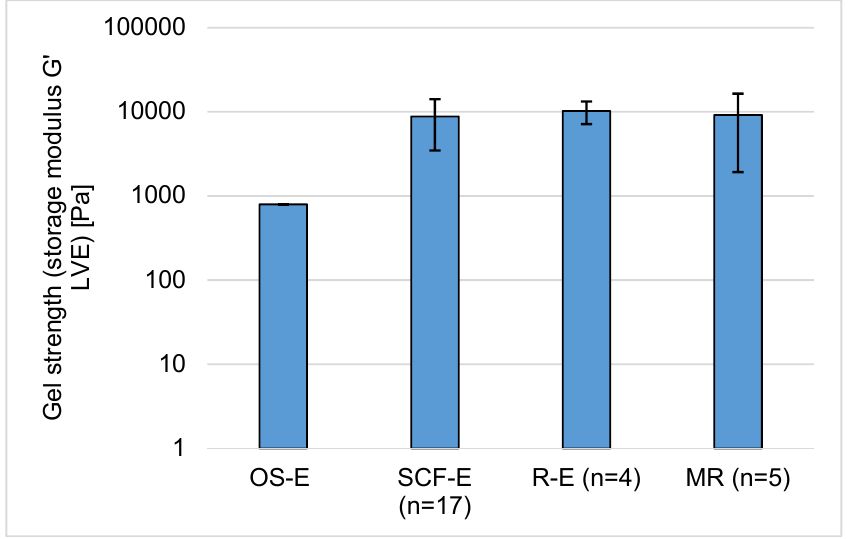
Figure 6. Gels stabilised by different types of birch bark extract (gel strength: amplitude sweep (AS) after 24 h); mean ± SD.